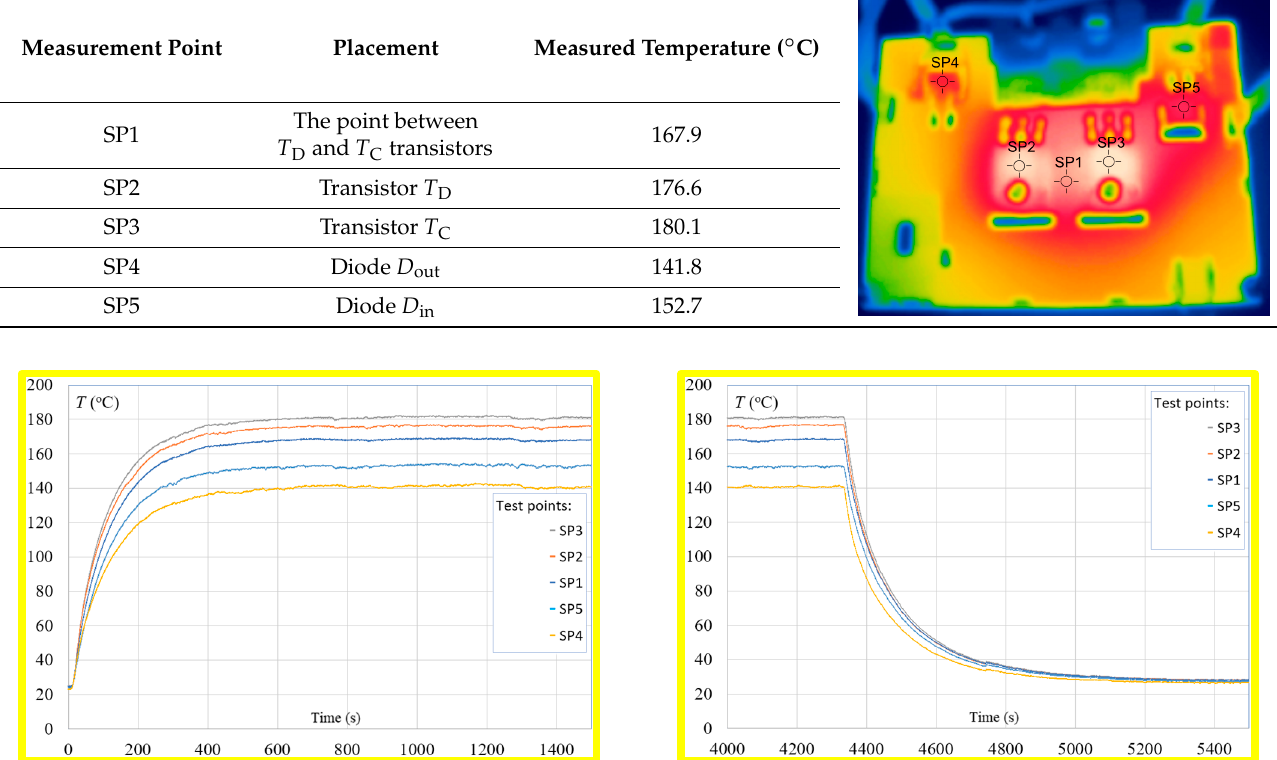
Figure 7. Experimental results of the temperature measurement in test points SP1–SP5 with the con-